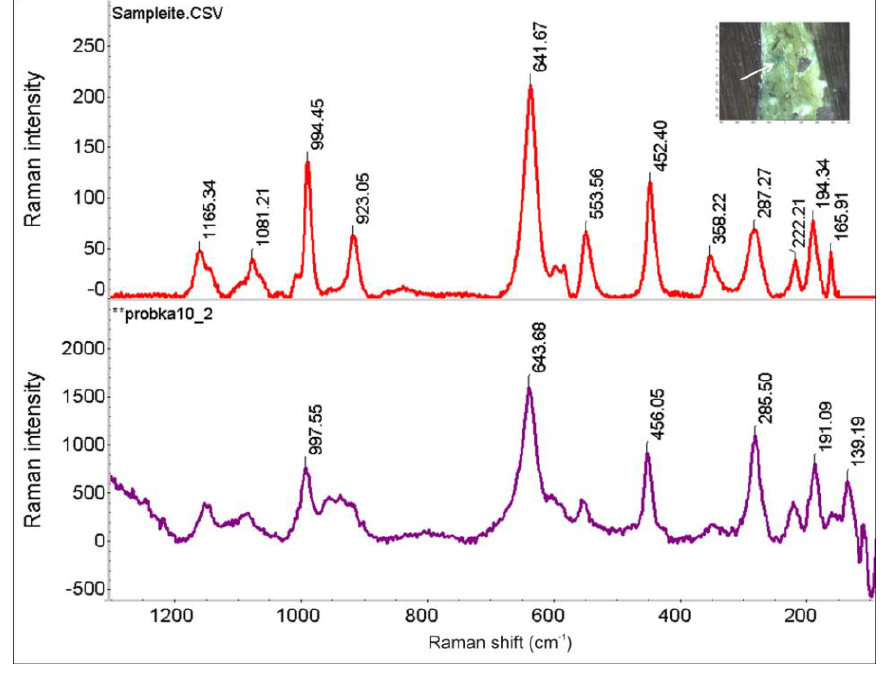
(PO ) Cl•5H O 5 4 4 2